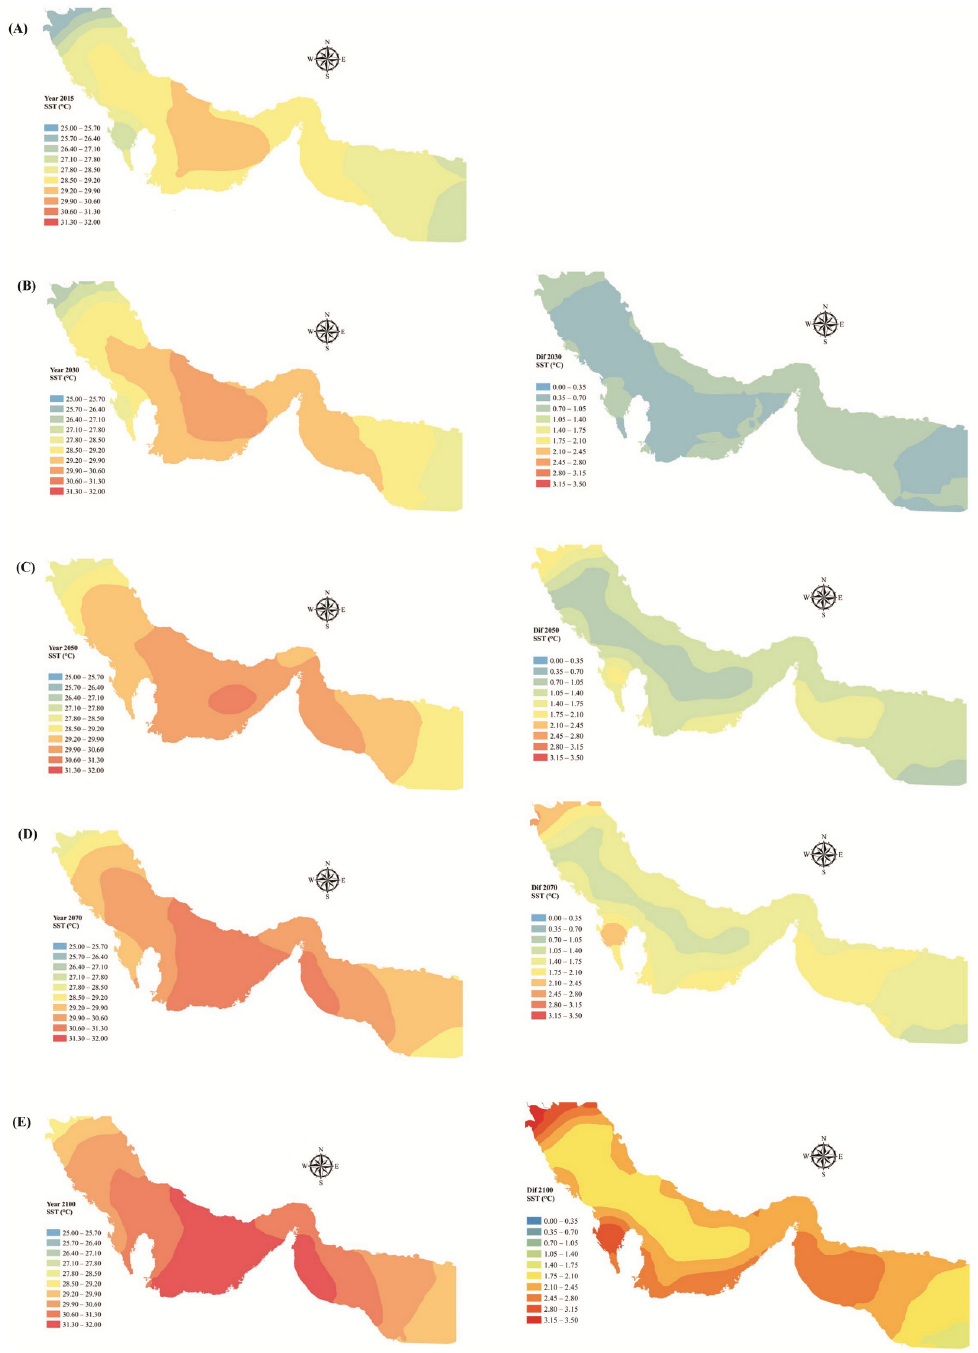
Fig 9. ( A ) Spatial distribution of mean annual sea surface temperature (SST) across the Persian Gulf & Gulf of Oman (PG&GO) for ( A ) the year 2015, ( B ) the year 2030 and difference between 2030 and 2015, ( C ) the year 2050 and difference between 2050 and 2015, ( D ) the year 2070 and difference between 2070 and 2015, and ( E ) the year 2100 and difference between 2100 and 2015.